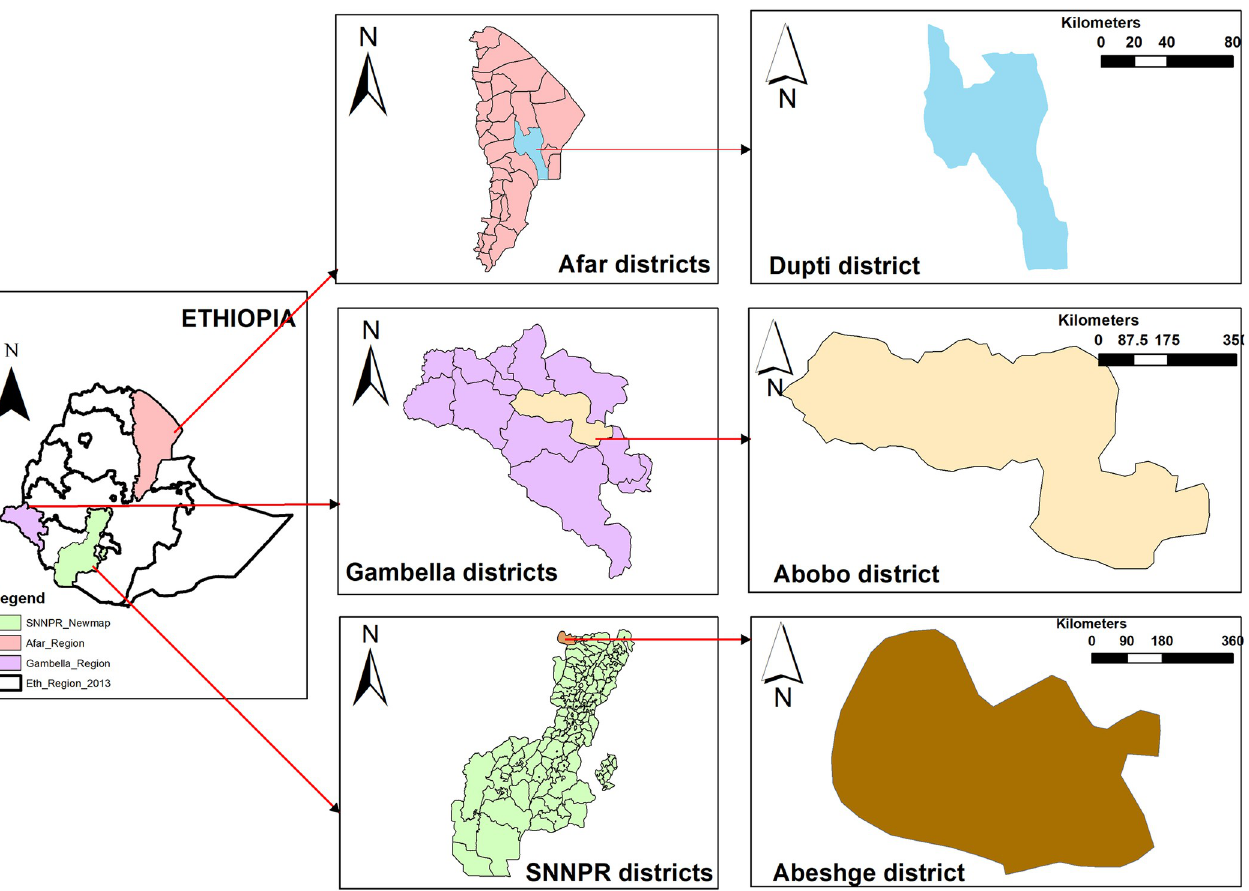
Fig 1. Localization of study area (shape files taken from: https://ethiopia.africageoportal.com/search?collection=Dataset).